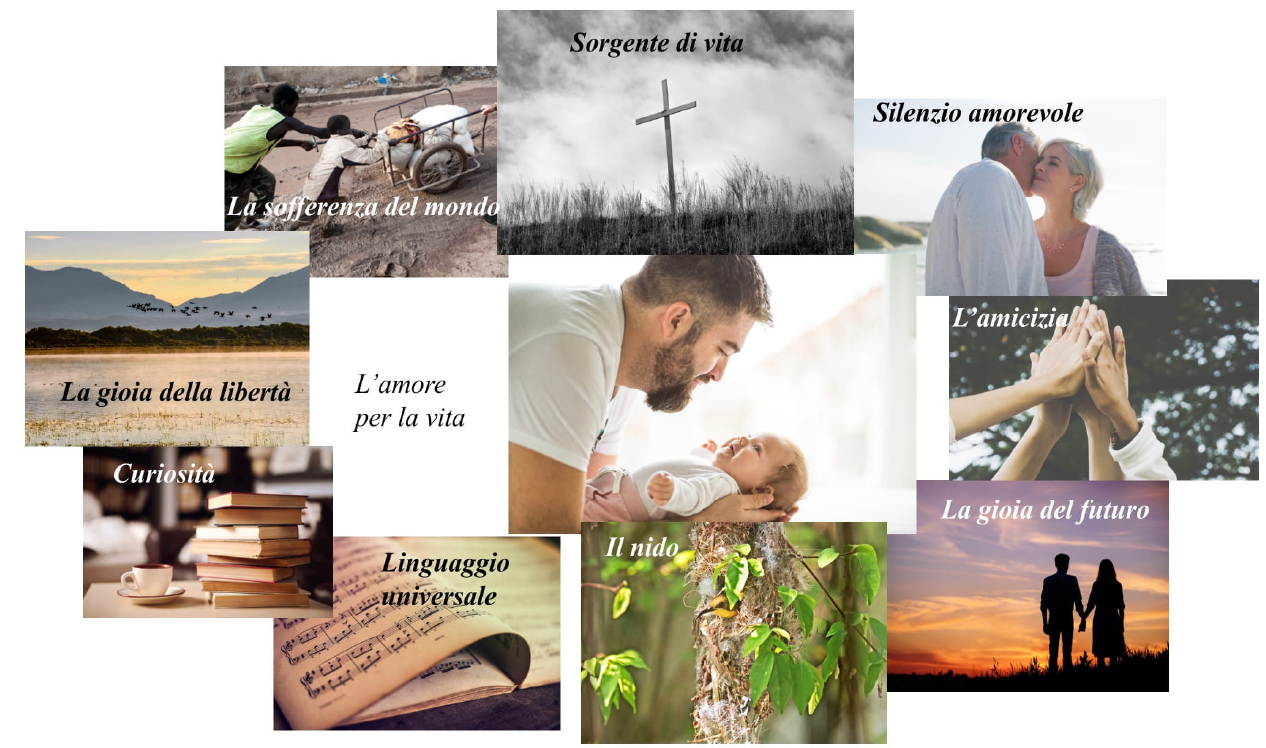
love”; “Friendship”; “Joy for the future”; “The nest”; “Universal language”; “Curiosity”; “Joy for freedom”; “The suffering of the world”. Figure 7. Elena’s photocollage: “Love for life”. Reproduced with permission from www.istockphoto.com (accessed on 5 June 2021; 7 June 2021; 11 July 2021).